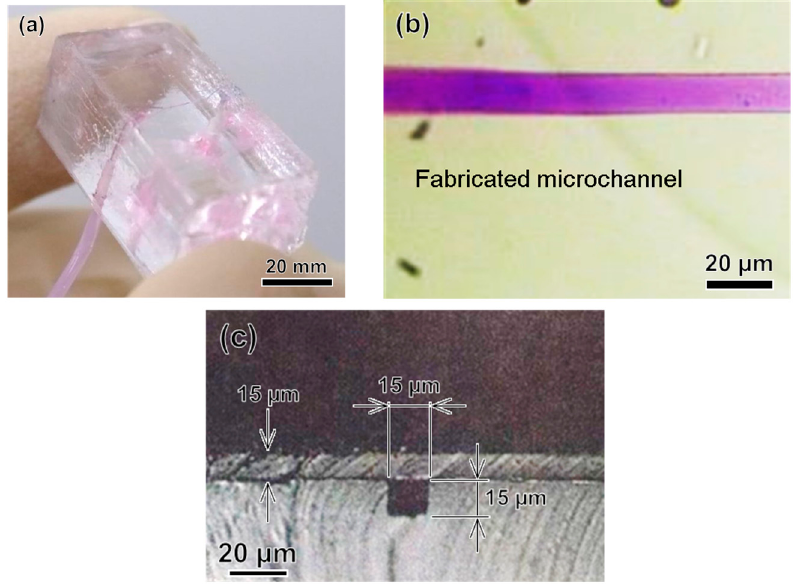
Figure 8. Images of the microchannel fabricated using classical photolithography. ( a ) PDMS base model with the microchannel; ( b ) Optical microscope image of the microchannel; ( c ) Cross-section of the microchannel